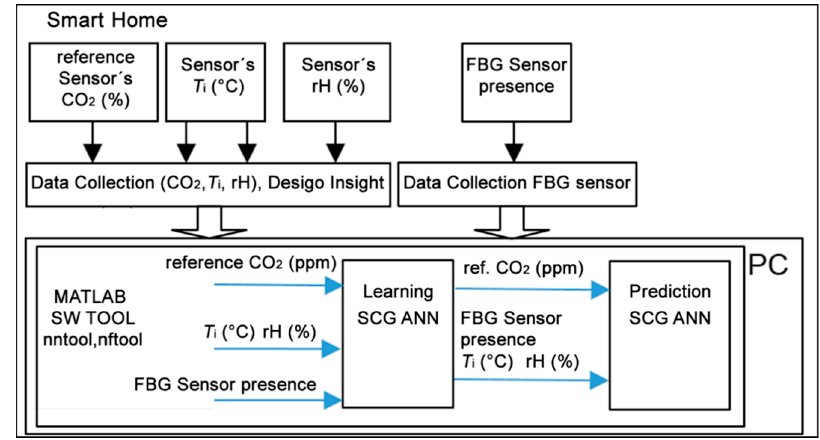
Figure 9. Block diagram describing processing of the data measured by means of a scaled conjugate gradient artificial neural network (ANN SCG) within the method devised for CO 2 prediction.